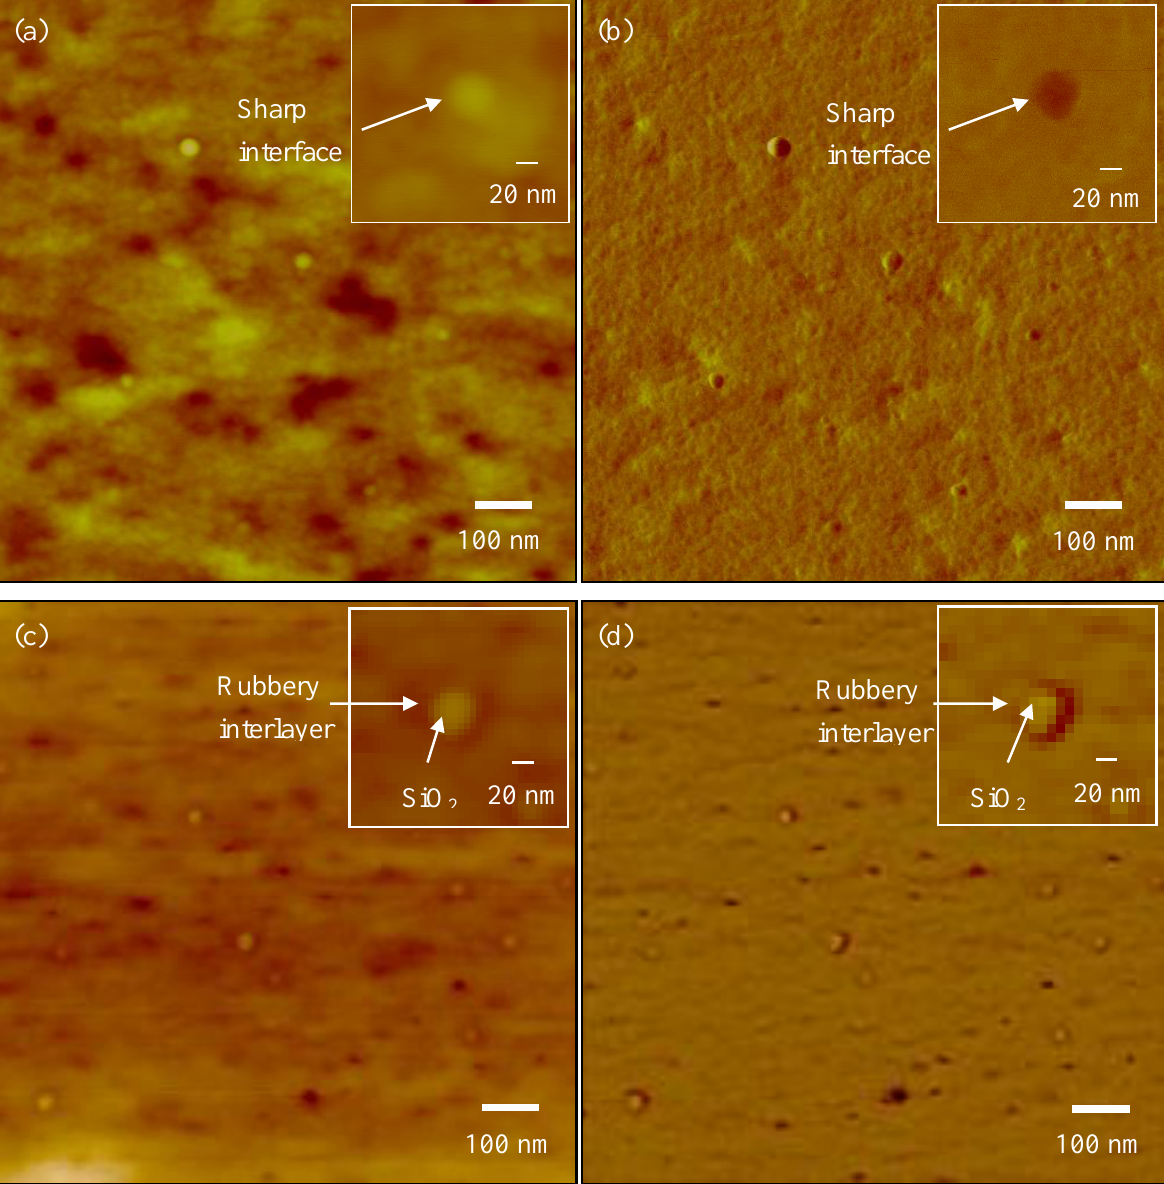
/epoxy; ( b ) AFM phase image of 2 2